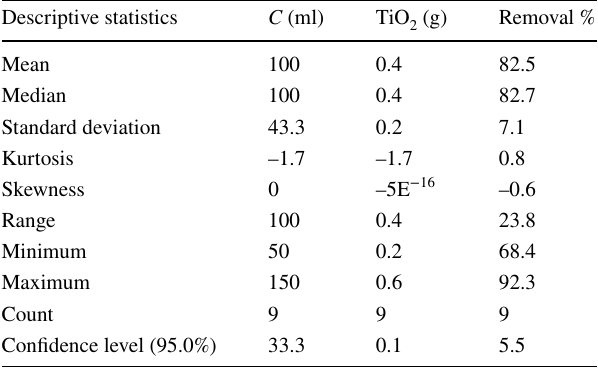
experimental design. The final equations obtained in terms 2 model of actual factors for the removal percentage for time ( R t ),